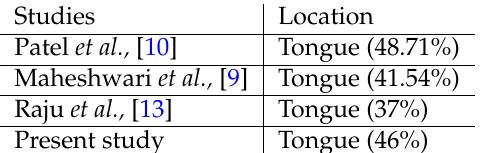
Table 5. Site of tumour in relation with other studies